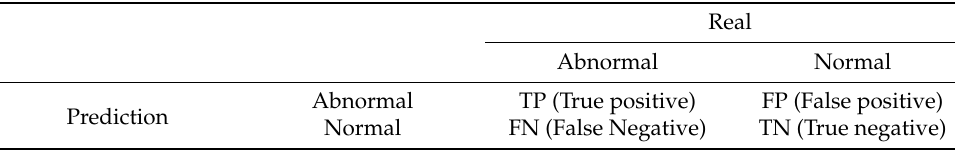
Table 1. Evaluation metrics for